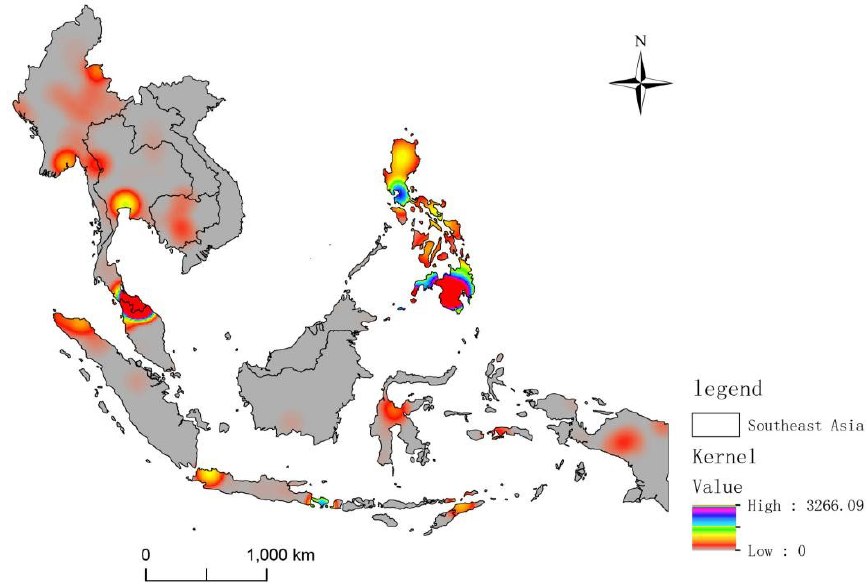
Figure 8. Kernel density map.